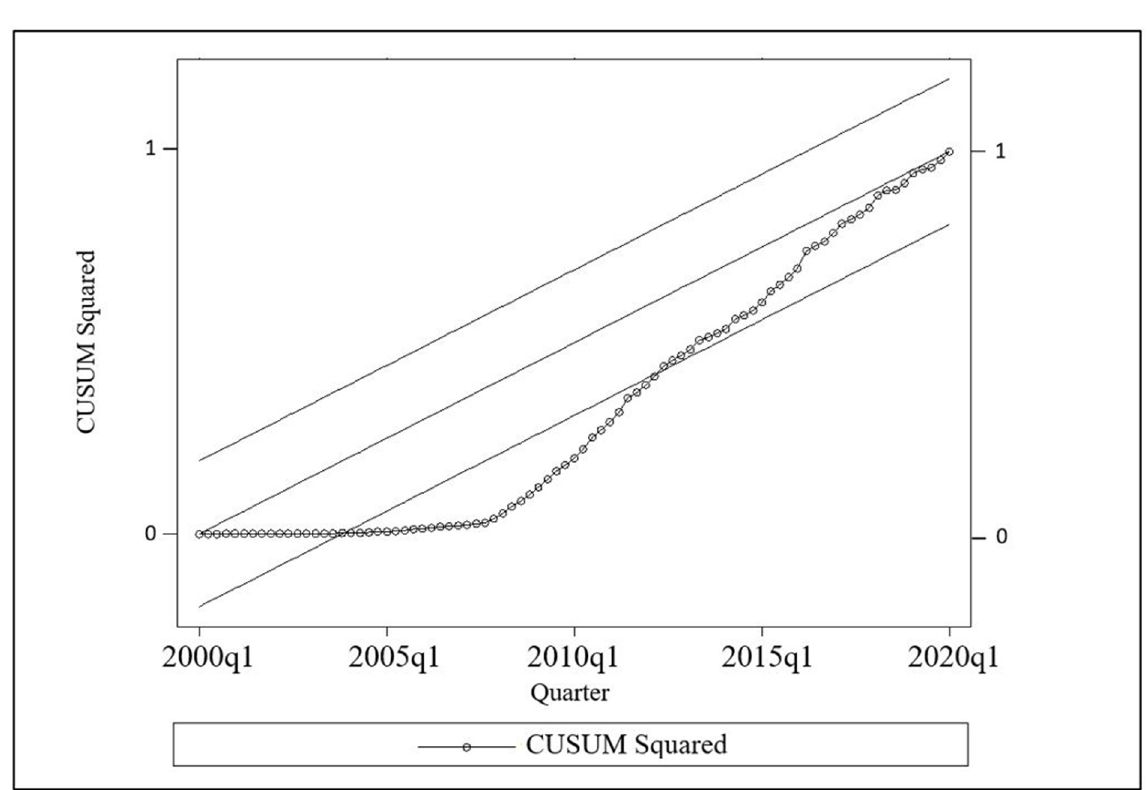
Fig 4. Results of CUSUM squared. Source: Authors’ illustration based on CBSL [56] and DCS [57].